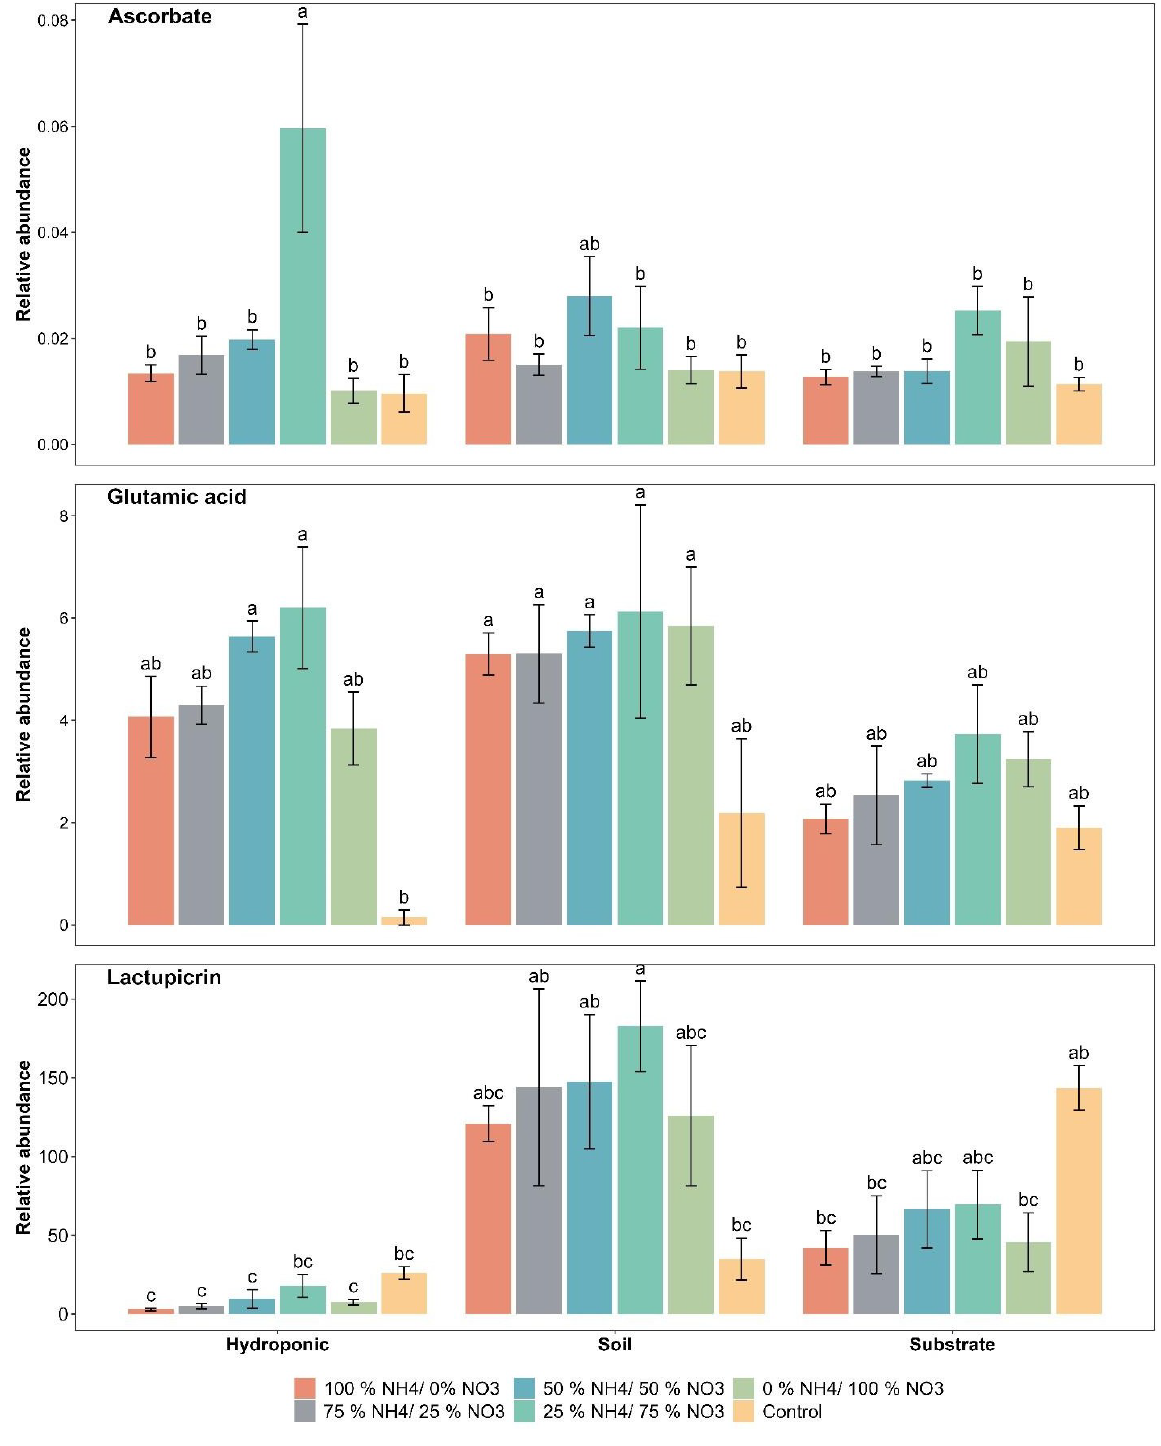
Figure 3. Effect of various applied NH 4+ /NO 3 − ratios (100:0, 75:25, 50:50, 25:75 and 0:100%) and control (no additional N applied) on taste and quality-related compounds in lettuce grown in soil, substrate and hydroponic cultivation systems. Note- The means ( n = 4) ± standard errors are shown in the data. Different letters (a–c) show significant difference ( p = 0.01) among applied NH 4+ /NO 3 − ratios (100:0, 75:25, 50:50, 25:75 and 0:100%) and control in lettuce grown in soil, substrate and hydroponic cultivation systems.